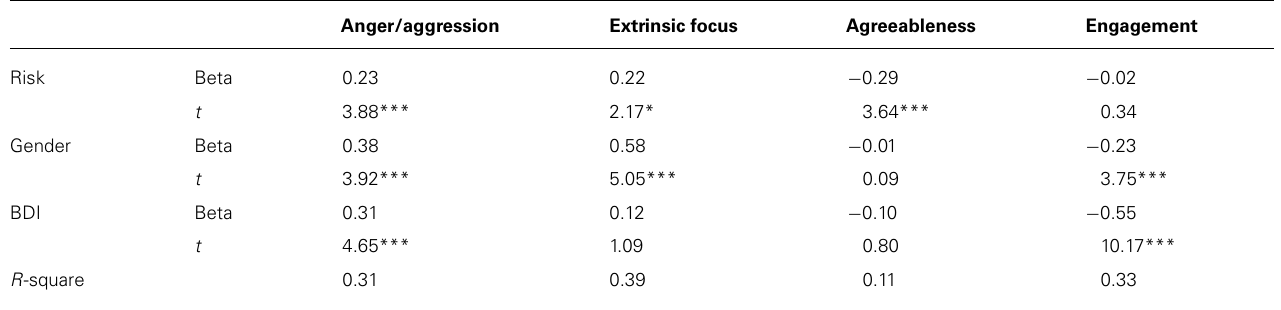
Table 4 | Standardized regression coefficients (betas) and t values for self-reported childhood adversity (Risk), gender, and concurrent depression scores (BDI), from a structural equation model predicting four latent personality factors ( n = 375).